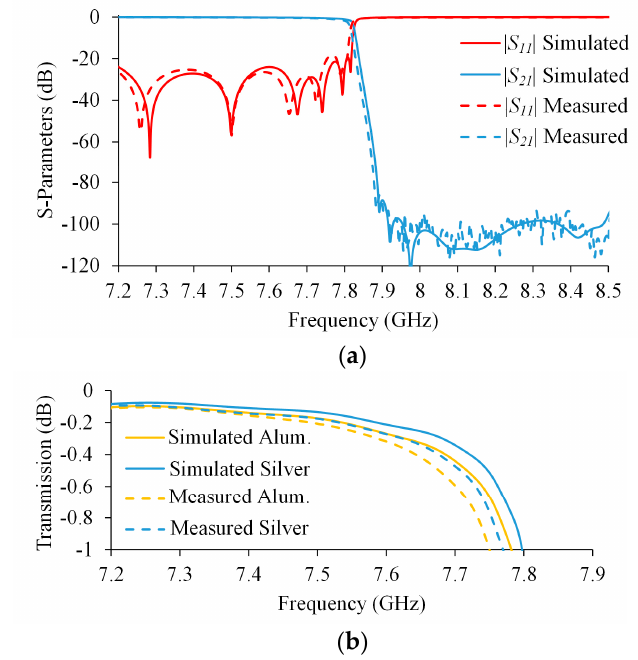
Figure 13. Comparison between measured and simulated results of the Rx filter. ( a ) Full scale reflection and transmission for the silver-plated version, ( b ) zoomed transmission in the band of